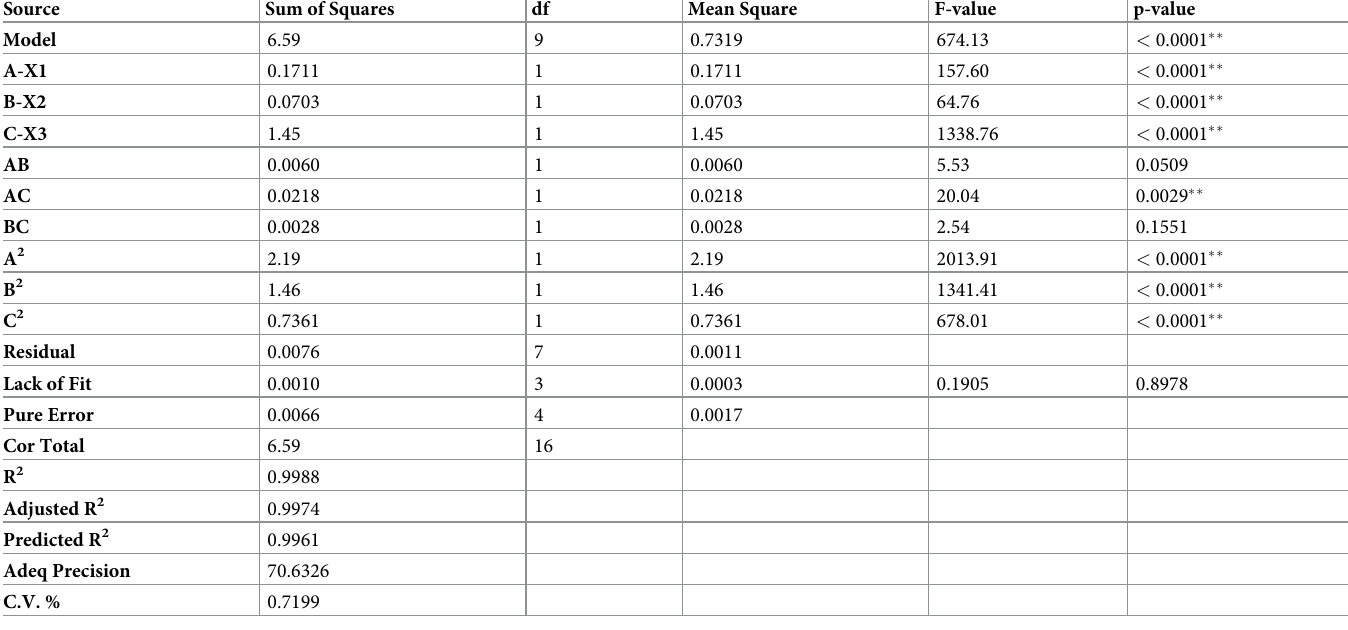
Table 2. ANOVA analysis for the quadratic model of POP